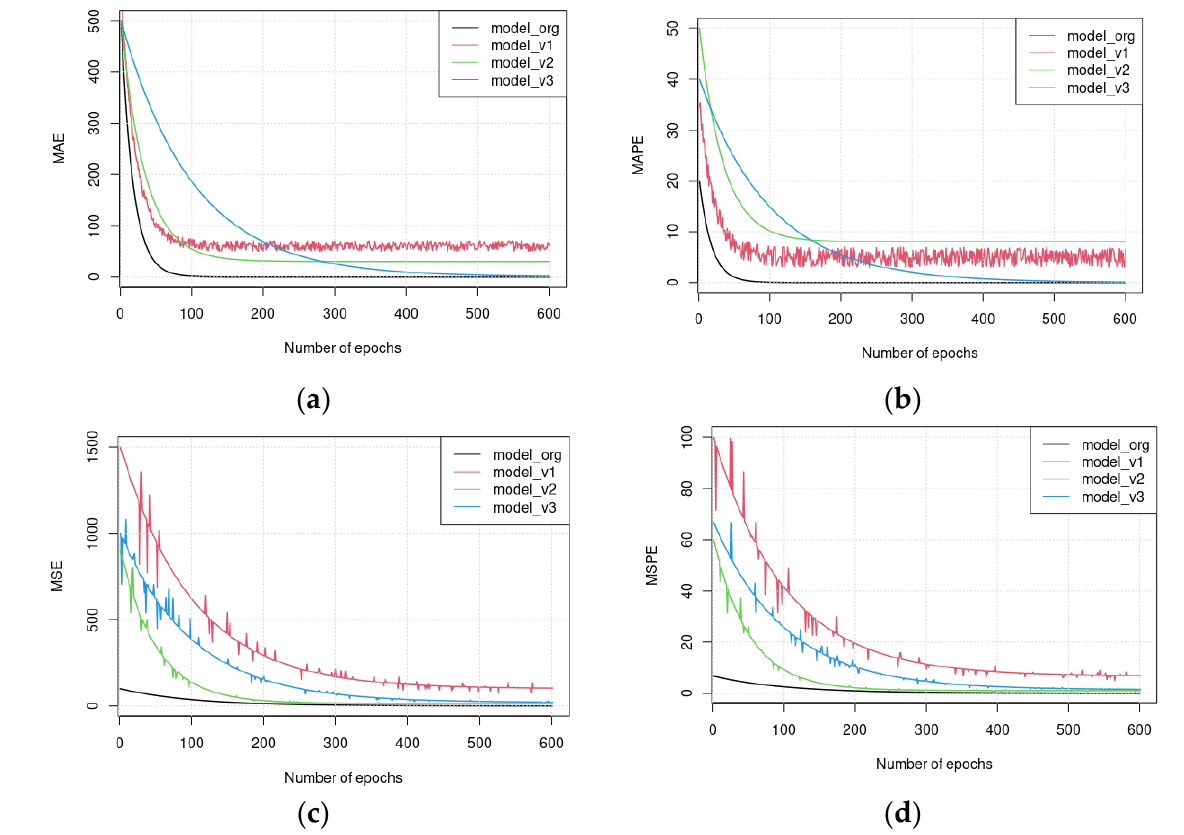
Figure 8. ( a ) MAE, ( b ) MAPE, ( c ) MSE, and ( d ) MSPE of the proposed model and its variants. In general, it can be seen from Figure 8a that the MAE characteristics of all models at initial learning phases are about the same, the highest values of the MAEs readings are recorded at epoch 0 and then they start to decay as more epochs elapsed. Nevertheless, the rate at which decay occurs and the region in which decay stops vary significantly between these models. It is clear, for example, that this model reaches the zero region in less than 100 epochs, whereas other models need more time to reach the same region or settle to a nonzero region. This superior performance can be attributed to the fact that model_org is able to encode all possible relationships between satellite images and phenotyping datasets, using both complementary and contextual learning approaches. Consequently, model_org consolidates learning over time, resulting in a continuous decrease in the difference between the value generated by the model and its corresponding ground truth. Furthermore, the characteristics of other models that have MAE are consistent with this interpretation. The characteristics of model_v3 reveal that removing the complementary learning approach and depending on the imaging part of the dataset delay approaching the zero-MAE-region by roughly five-folds compared to model_org. The delay can be attributed to the extensive processing power needed to extract salient features from images and then incorporating them into the learning hypothesis of the model. As shown in Table 2, manipulating a single instance of image requires 123,008 units whereas manipulating a timeseries instance requires only 200 units. This comparison highlights the benefit of using timeseries instead of images as training datasets, however, dataset, show a modest performance in comparison with other models. It is noteworthy